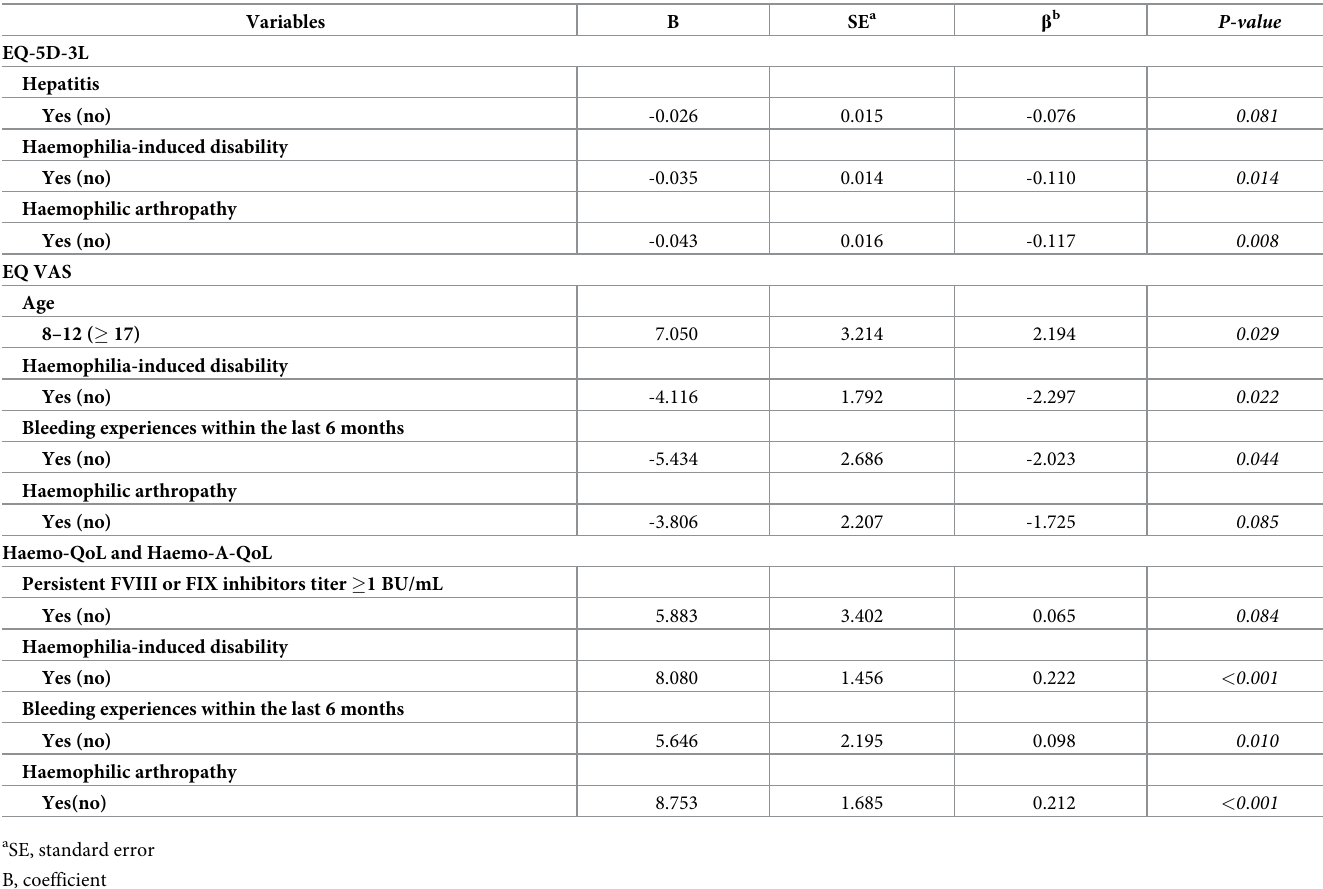
Table 4. Multivariate analyses for clinical factors associated with health-related quality of life according to the instrument used.